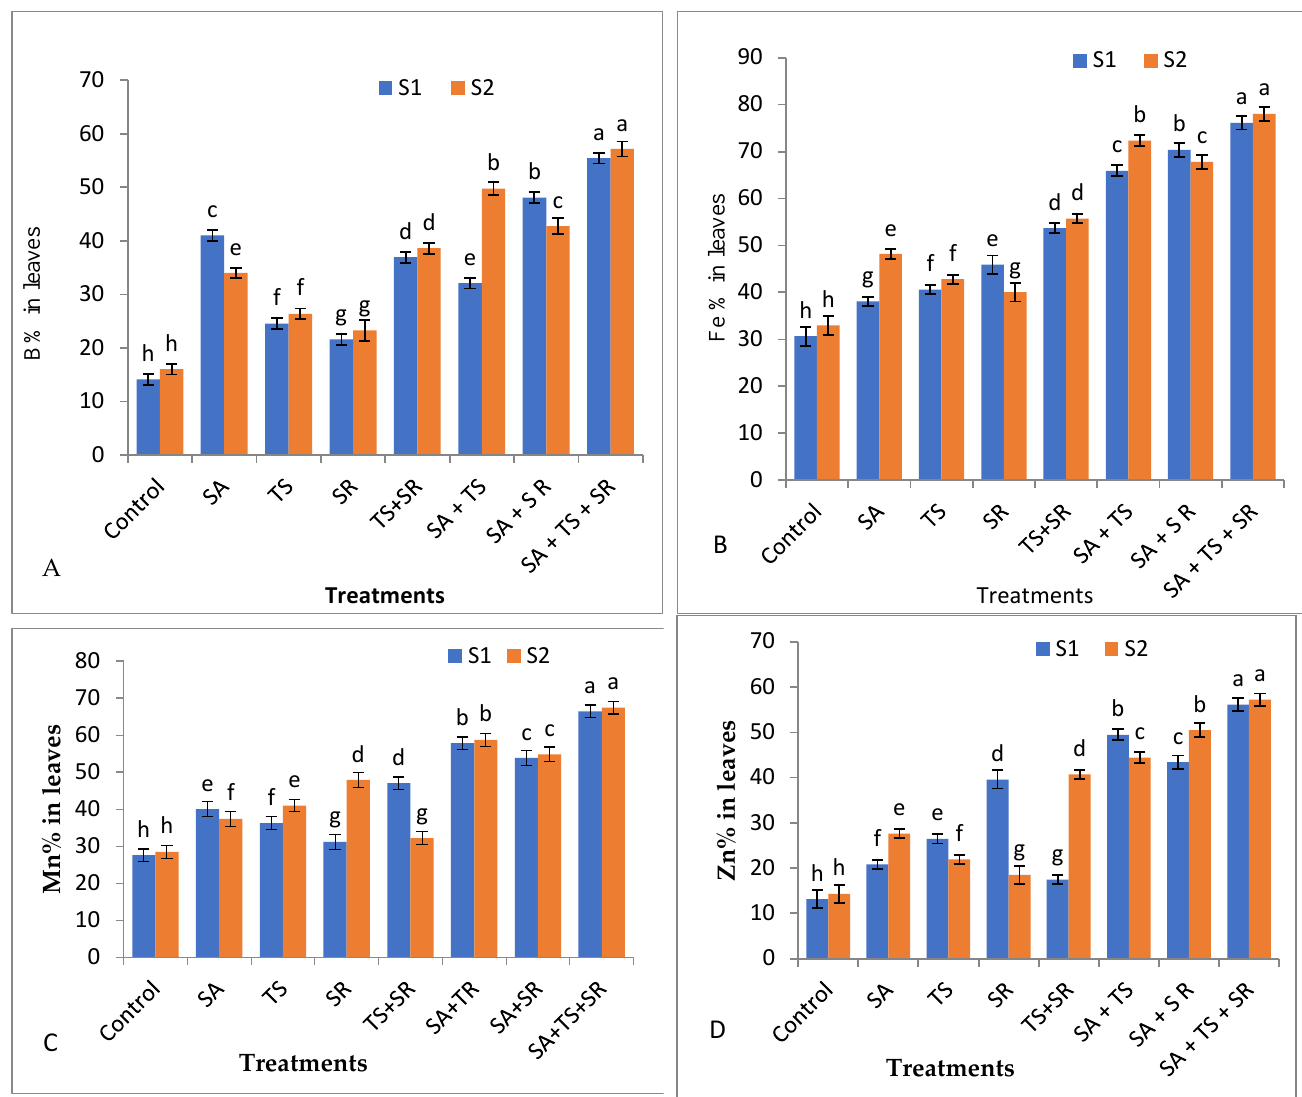
Figure 5. Effect of shikimic acid (SA) seed priming rates 40 ppm and foliar applications of water (control), T. asperellum (TS), S. rochei (SR), T. asperellum + S. rochei + (TS+SR), shikimic acid + T. asperellum(SA+TS), shikimic acid+ S. rochei (SA+SR), and shikimic acid + T. asperellum + S. rochei (SA+TS+SR) on ( A ) B%, ( B ) Fe%, ( C ) Mn%, and ( D ) Zn% in leaves during two seasons. Standard errors of the mean are shown as vertical bars; the LSD test indicates that differences between values in each bar that are marked by different letters are significant at p ≤ 0.05. 3.2.5. Antioxidant Enzymes, Total Phenols, and Plant Hormones in Squash Leaves